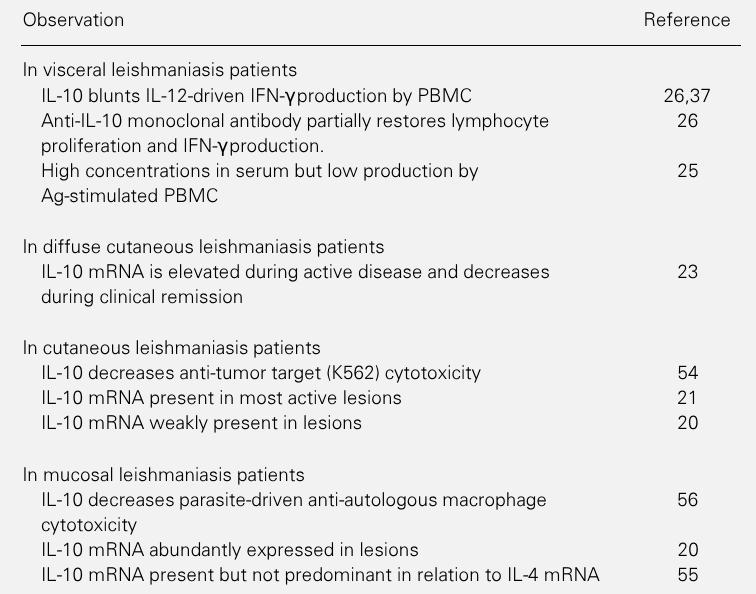
Table 3 - IL-10 in human leishmaniasis. Observation